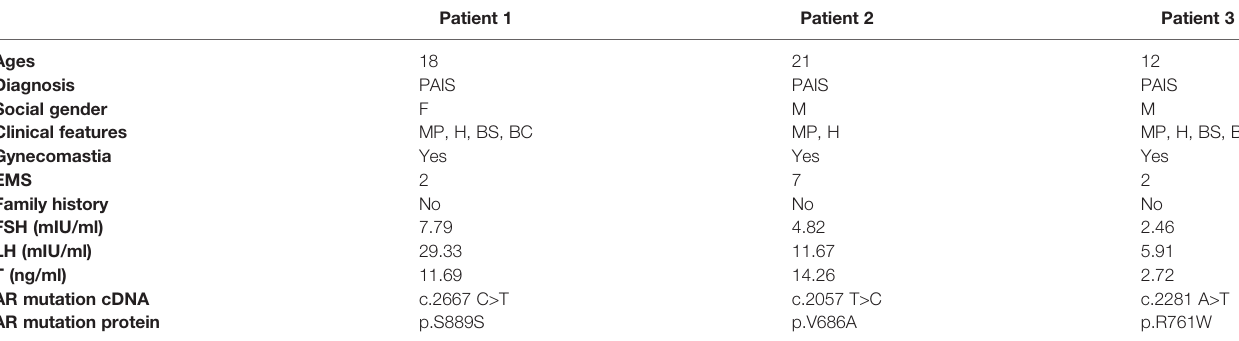
TABLE 1 | Clinical features, serum hormone, and AR mutations of three patients with